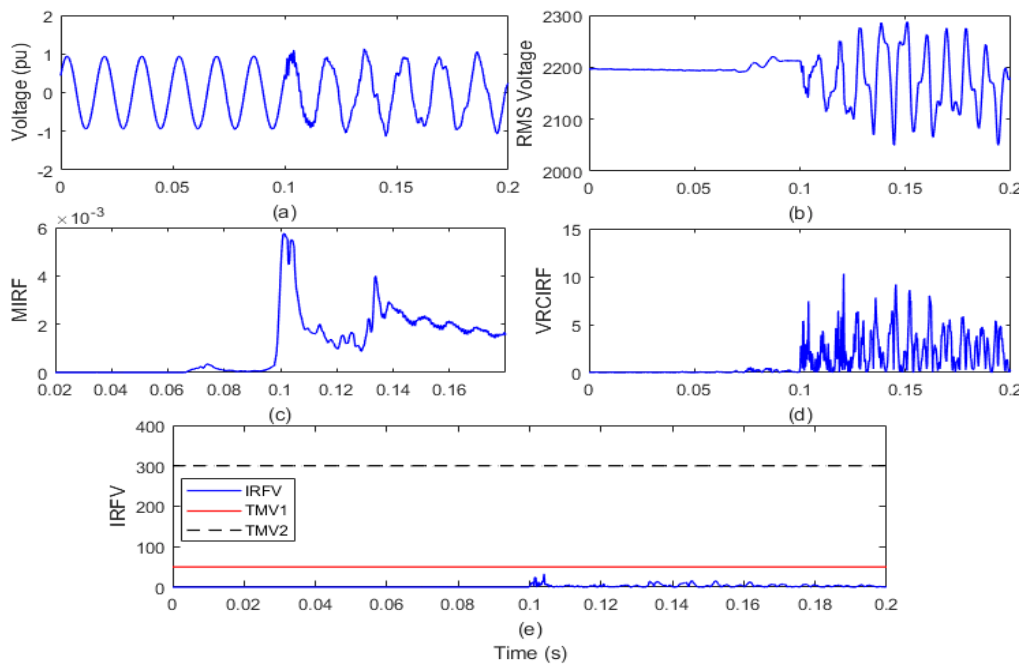
Figure 13. Synchronization of solar power plant (SPP) to grid ( a ) voltage signal ( b ) root means square value of voltage ( c ) median-based IRF ( d ) rate of change in voltage-based IRF ( e ) islanding recognition factor based on voltage.